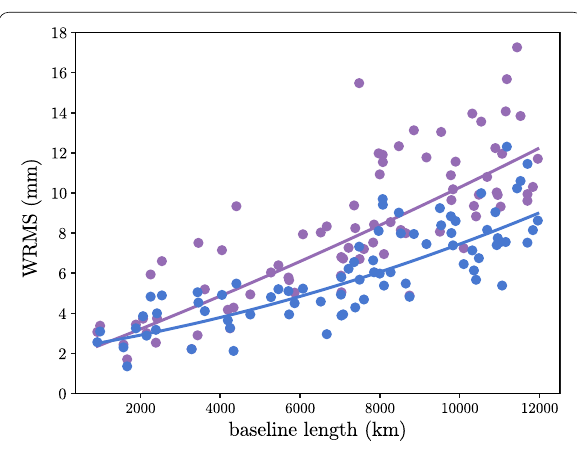
Fig. 10 Baseline length repeatabilities of sol‑V (blue) compared to sol‑VG (magenta) for the L1 network